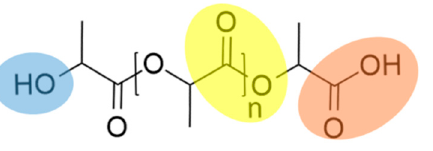
Figure 1. Chemical structure of PLA with its functional groups.